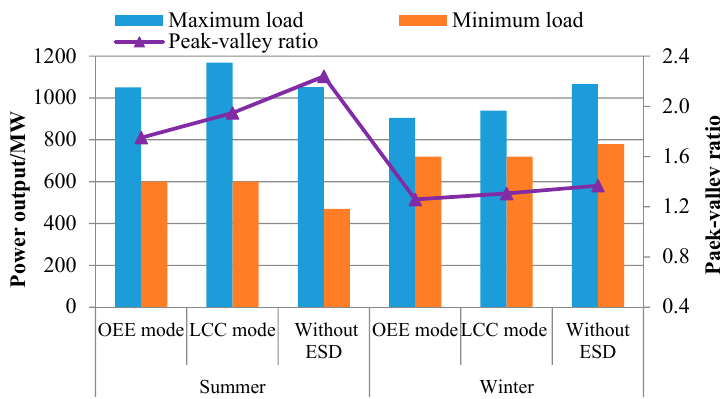
Figure 14. The net output curve of the thermal power units under different operational strategies.